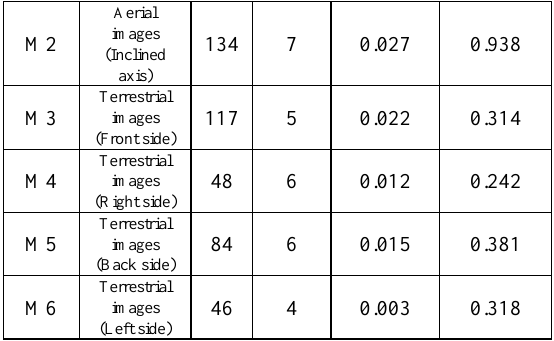
Table 3. Cameras, GCPs and residual error of GCPs estimated by PhotoScan for each dataset.